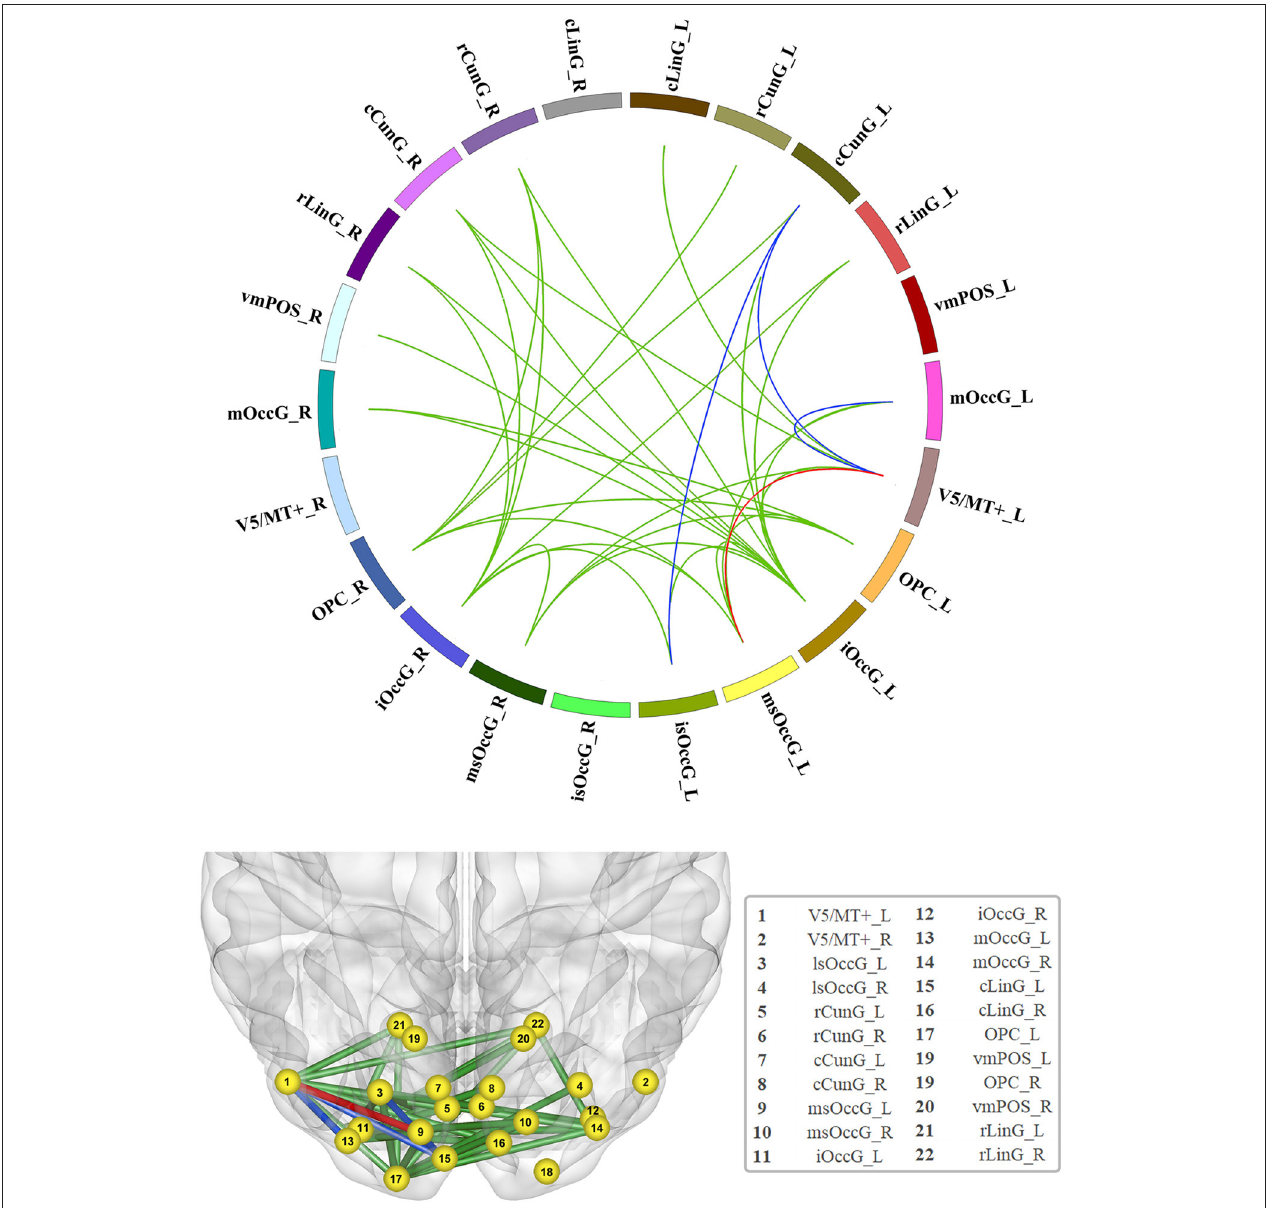
FIGURE 1 | Significant increase in functional connectivity (FC). The red line represents the edge of FC that was increased in the non-GRE group compared to the GRE and healthy groups. The blue lines represent the edges of FC that were increased in the non-GRE group compared to the GRE group. The green lines represent the edges of FC that were increased in the non-GRE group compared to the healthy group.